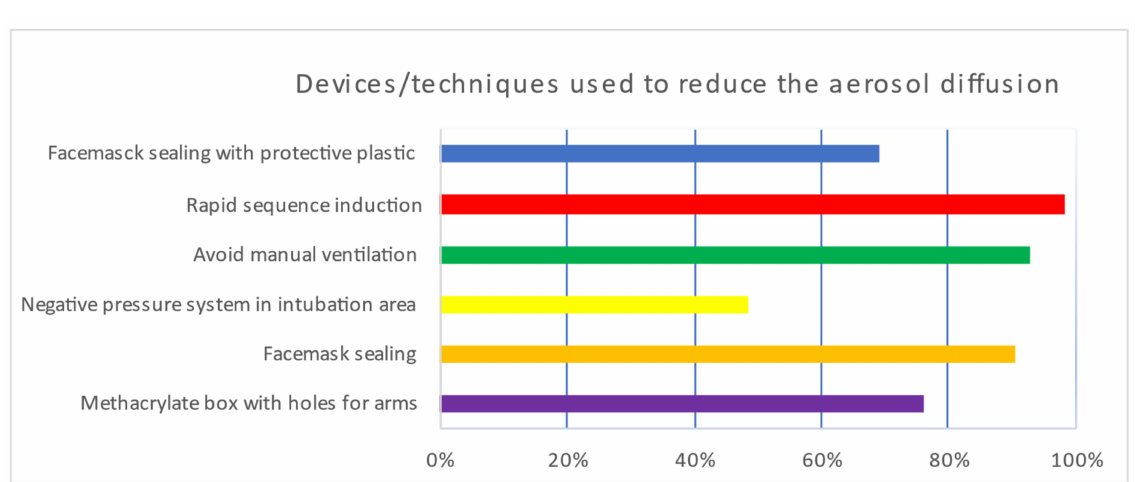
Figure 4. Used techniques to reduce aerosol diffusion during tracheal intubation in COVID-19 patients. Percentage